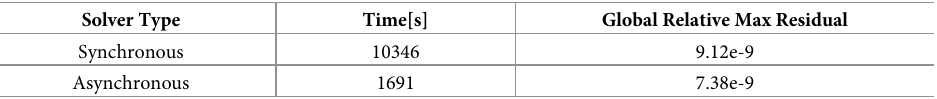
Table 2. Comparison of the performance of the synchronous solver (Algorithm A) and the asynchronous solver (Algorithm B) for the simulation setup specified in Table 1. The asynchronous solver achieves the accuracy thresh- old in much lesser